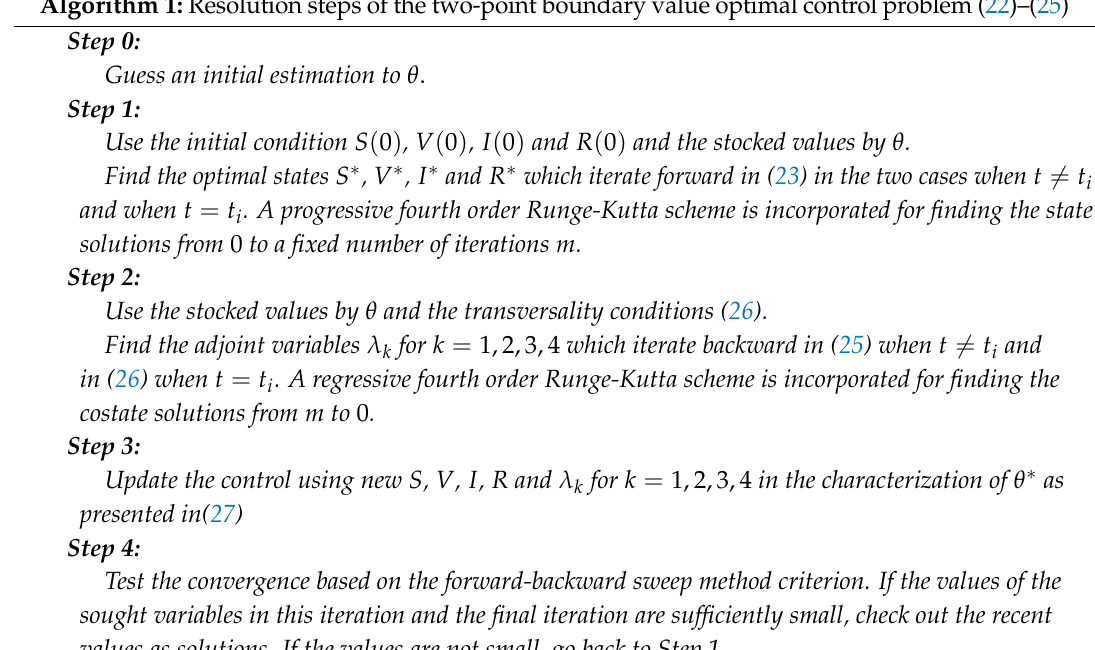
Algorithm 1: Resolution steps of the two-point boundary value optimal control problem